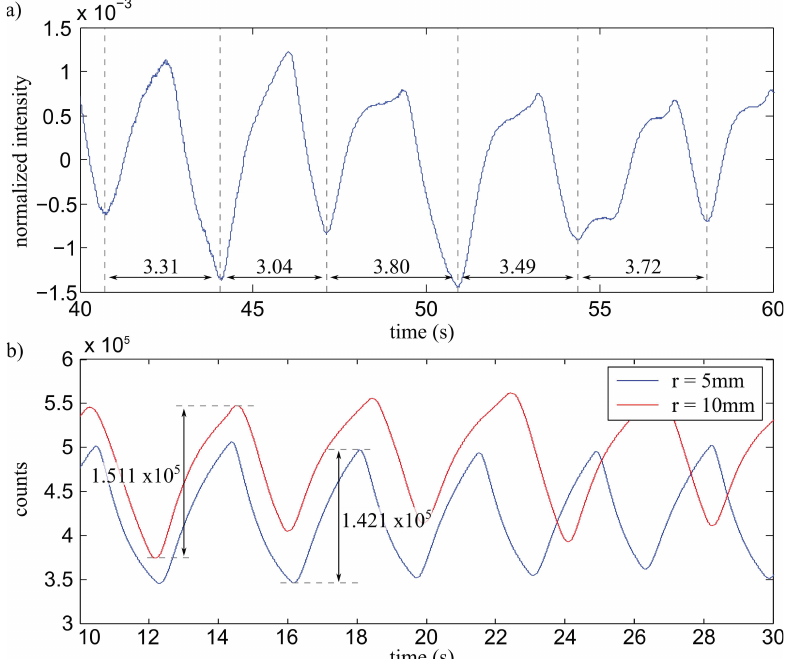
Figure 4. ( a ) Normalized measurement data of a person breathing inside the oxygen mask, filtered with a discrete first-order low pass filter (PT1) filter; ( b ) Absolute measurement data in counts, comparing two different U-bend sensors—one with a radius of 5 mm and one with a radius of 10